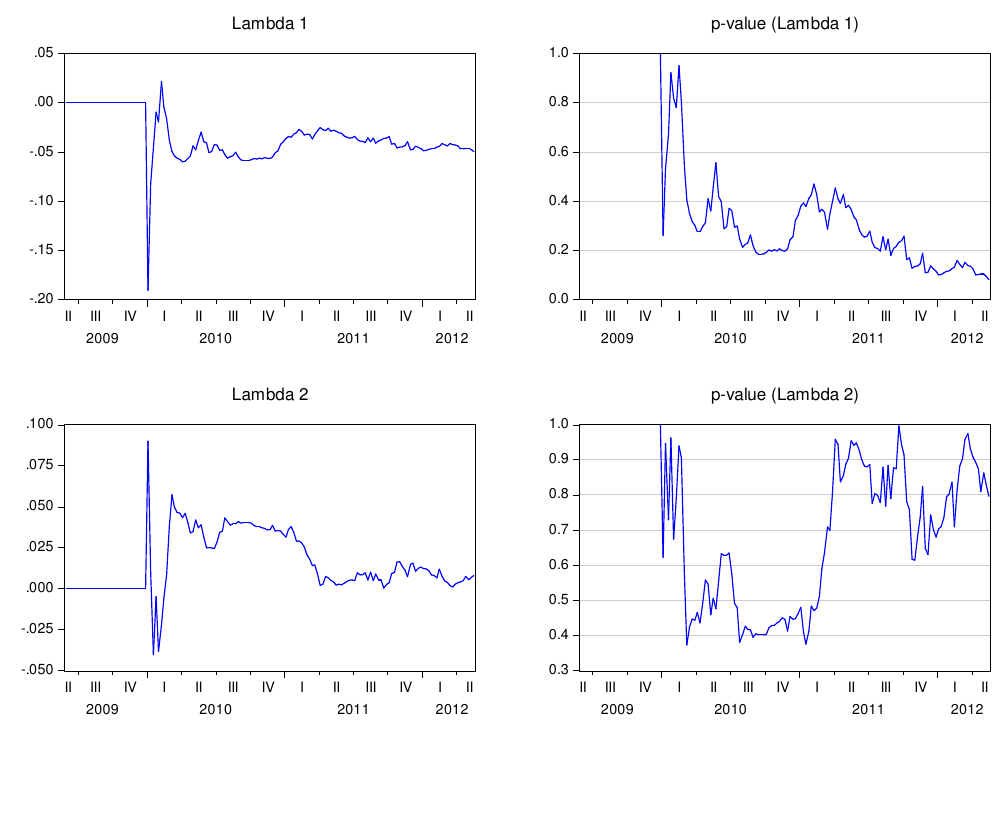
Figure 6. Recursive estimation of the speed adjustment parameters — Finland.